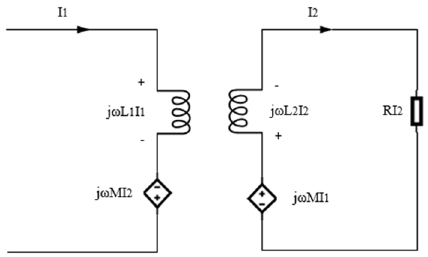
Figure 2. Current transformer equivalent circuit diagram.